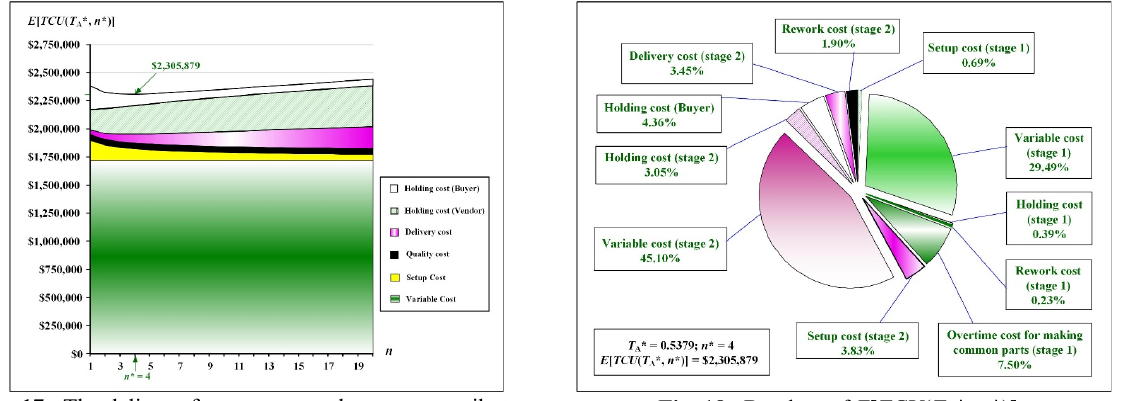
Fig. 18. Breakup of E [ TCU ( T A *, n *)]